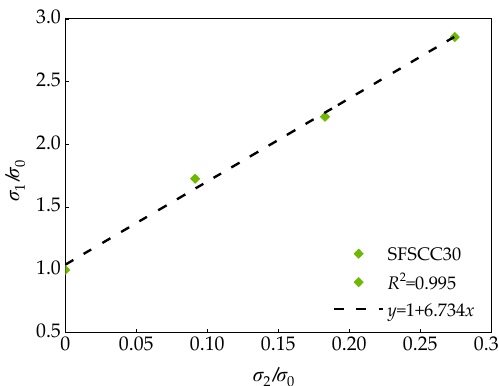
Figure 13. Relationship between peak stress and confining pressure of SFSCC30.